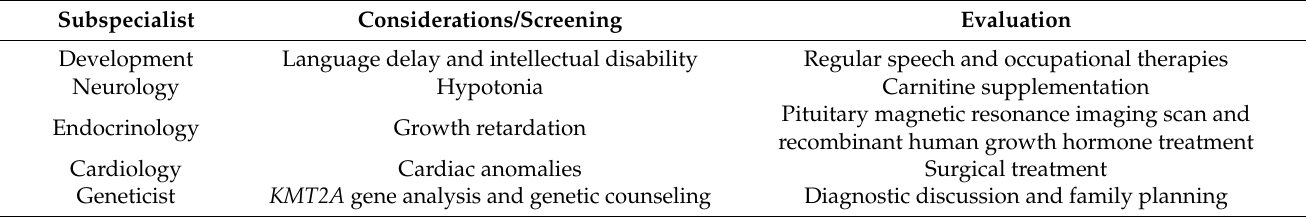
Table 1. Recommended multi-disciplinary plan of care for Wiedemann-Steiner